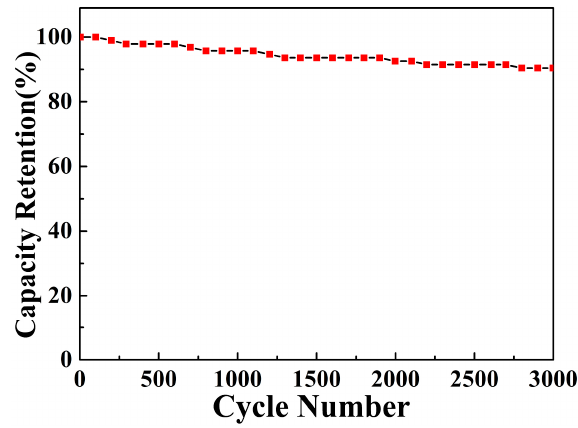
Figure 7. Cycling performances of the Ag@Ni(OH) 2 electrode.